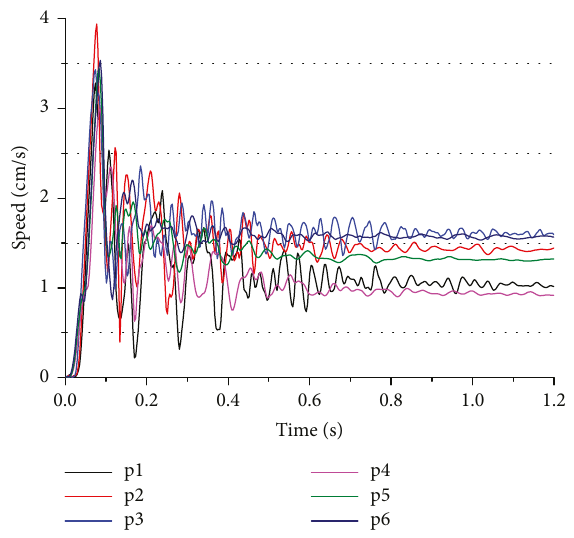
Figure 31: Time-history response curve of velocity at characteristic points on the embankment in the second